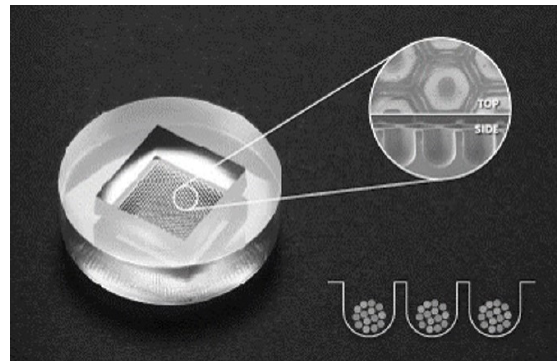
Figure 1. Stemfit 3D ® uses a non-adhesive plate with a polydimethylsiloxane-based concave mi- cromold 600 µm in diameter. It can control the size of spheroids and enhance their long-term sta- bility.